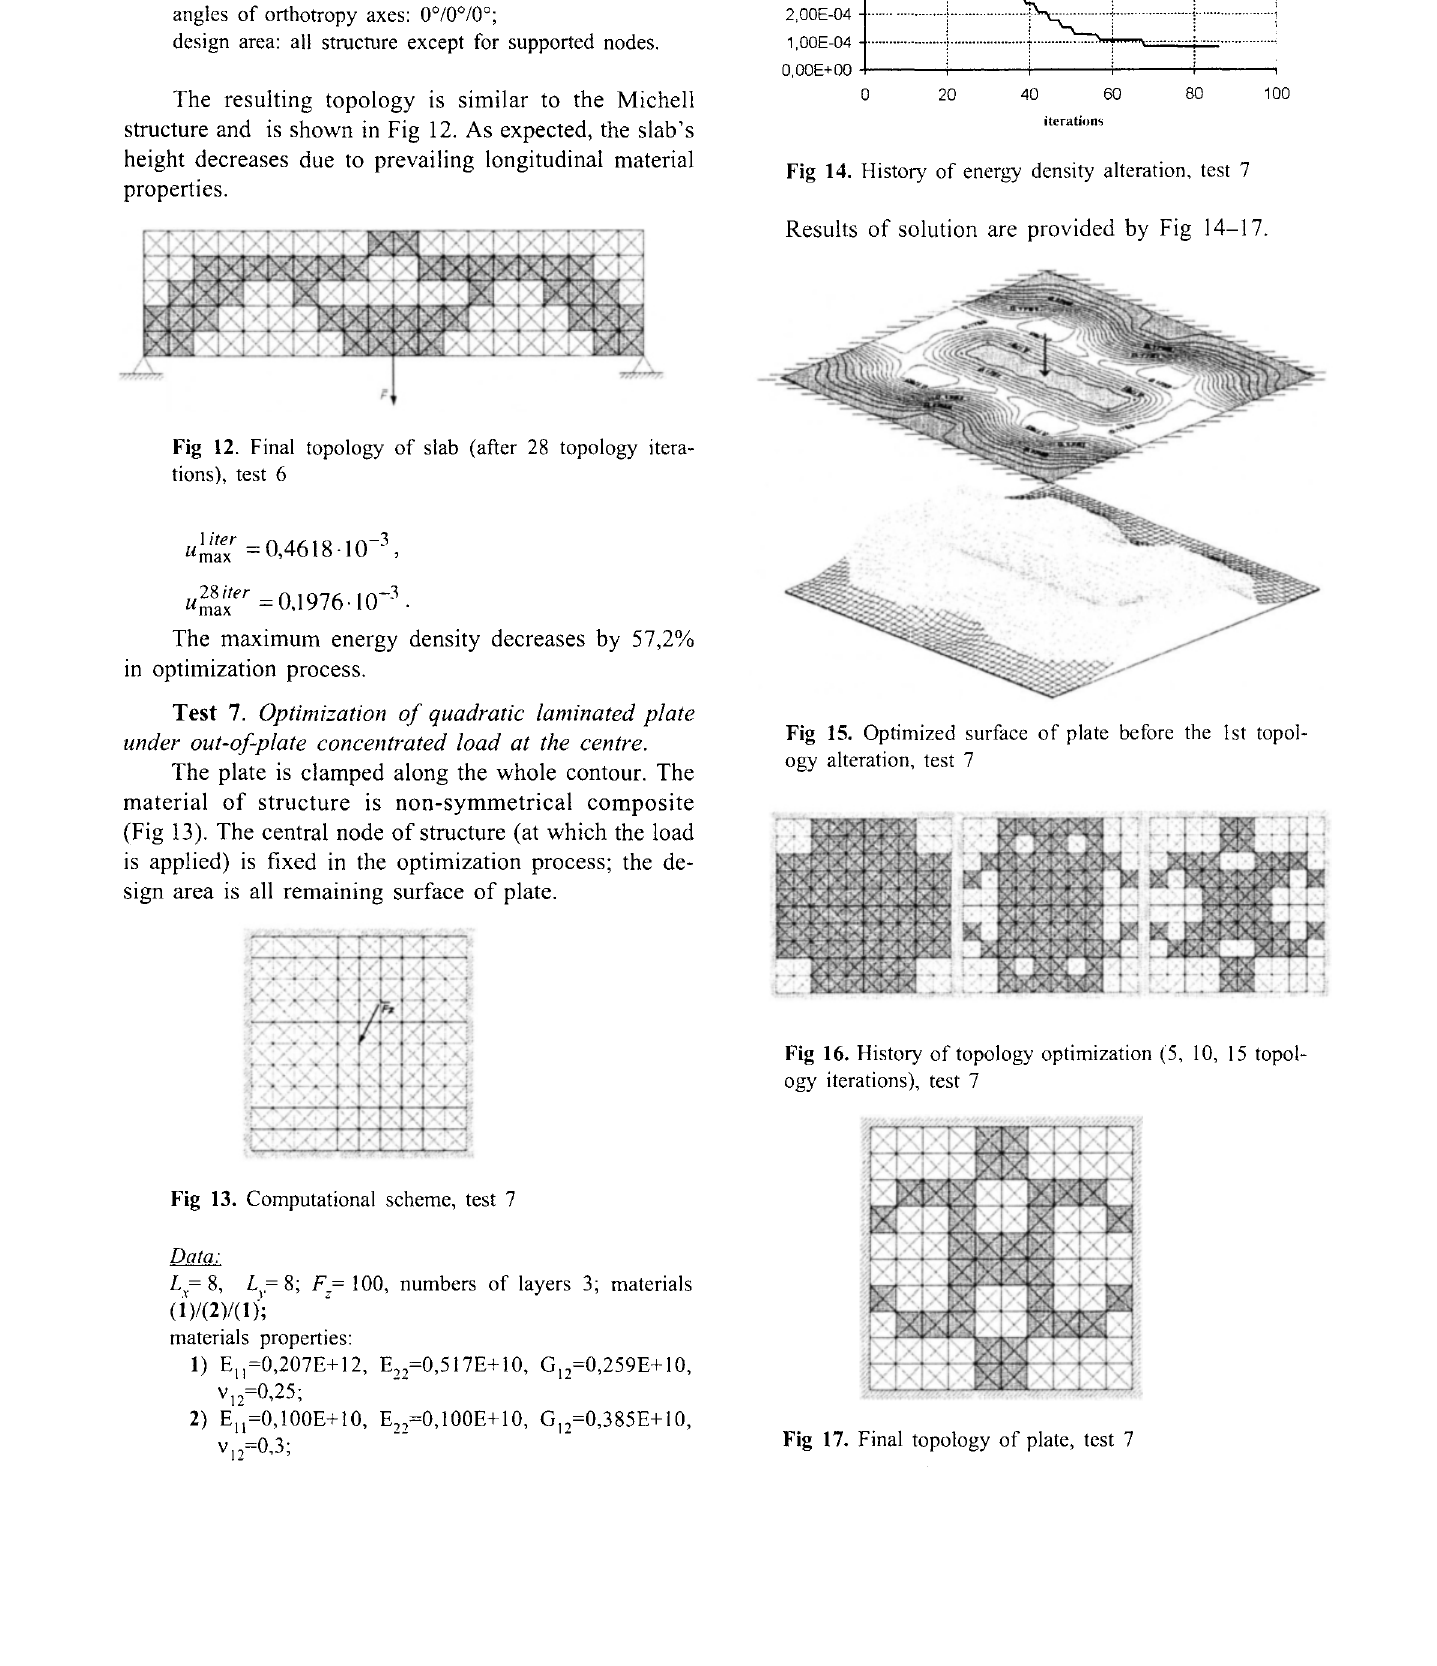
Fig 14. History of energy density alteration, test 7 Results of solution are provided by Fig 14-17.